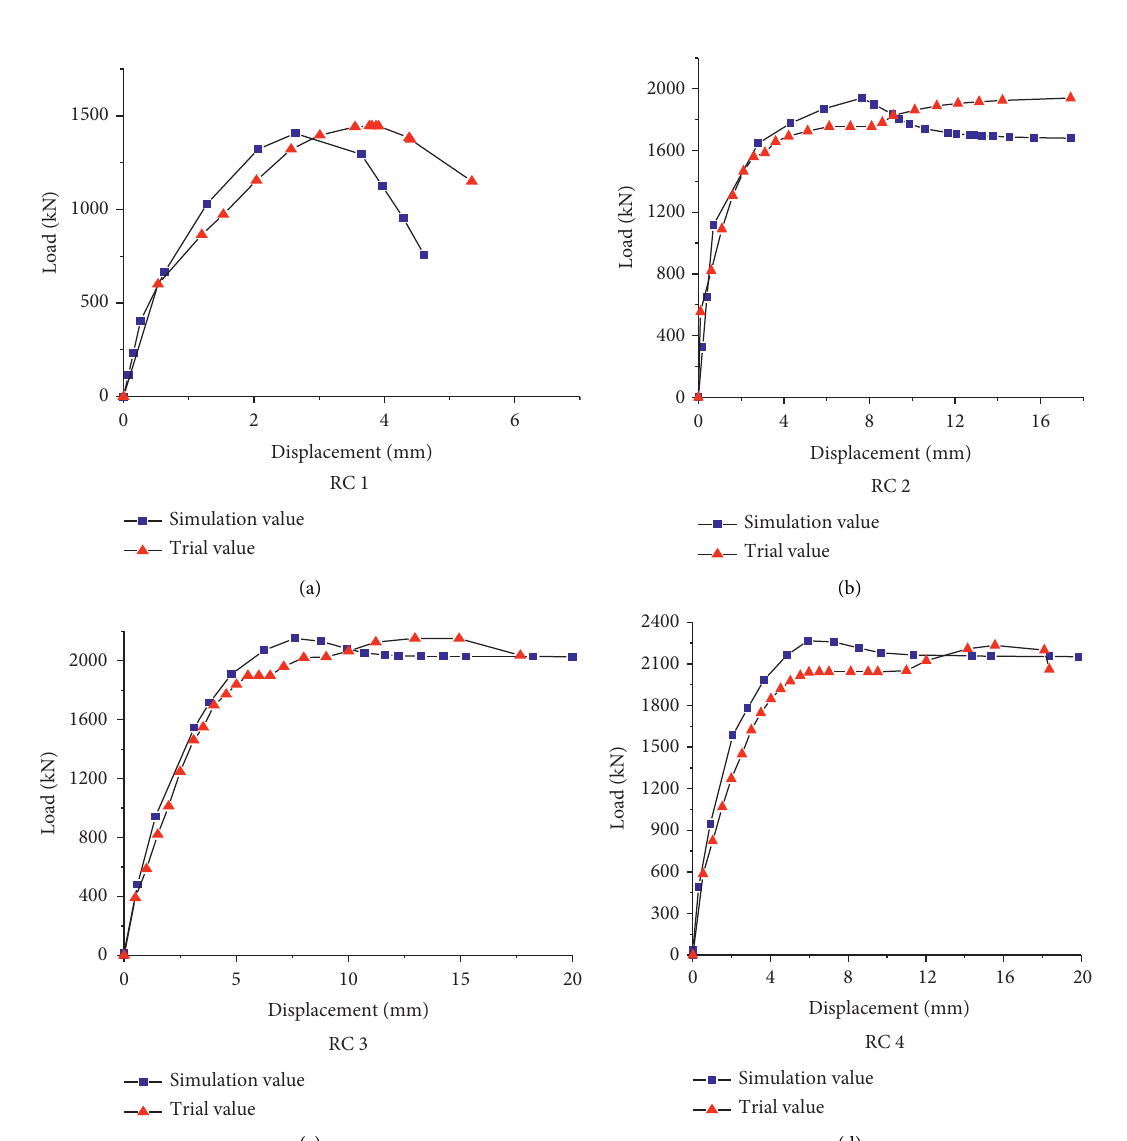
Figure 8: Comparison of load-displacement curves between test and simulation. (a) RC1, (b) RC2, (c) RC3, (d) RC4.